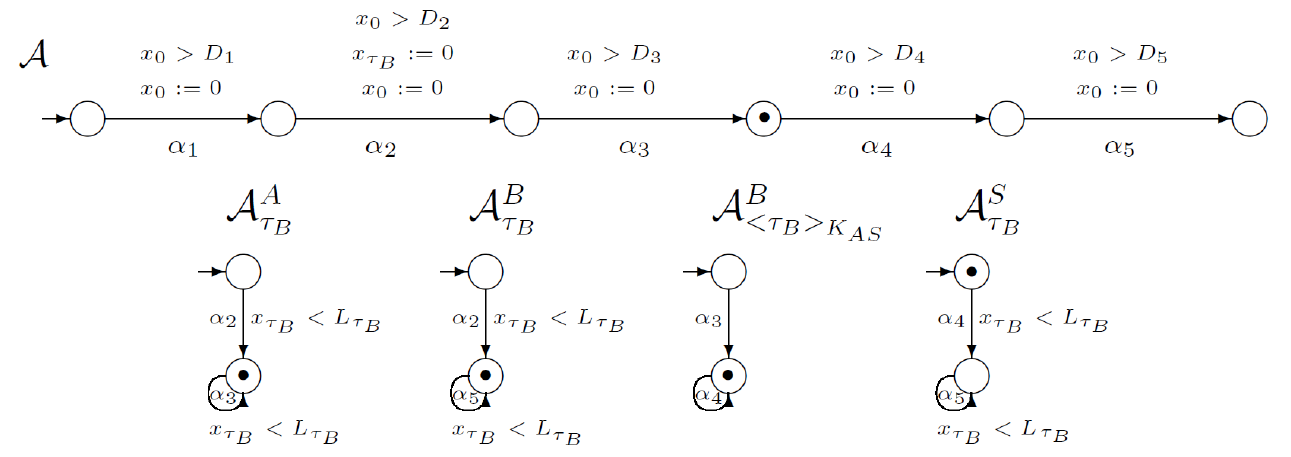
Figure 4. The third step of the WooLamPi